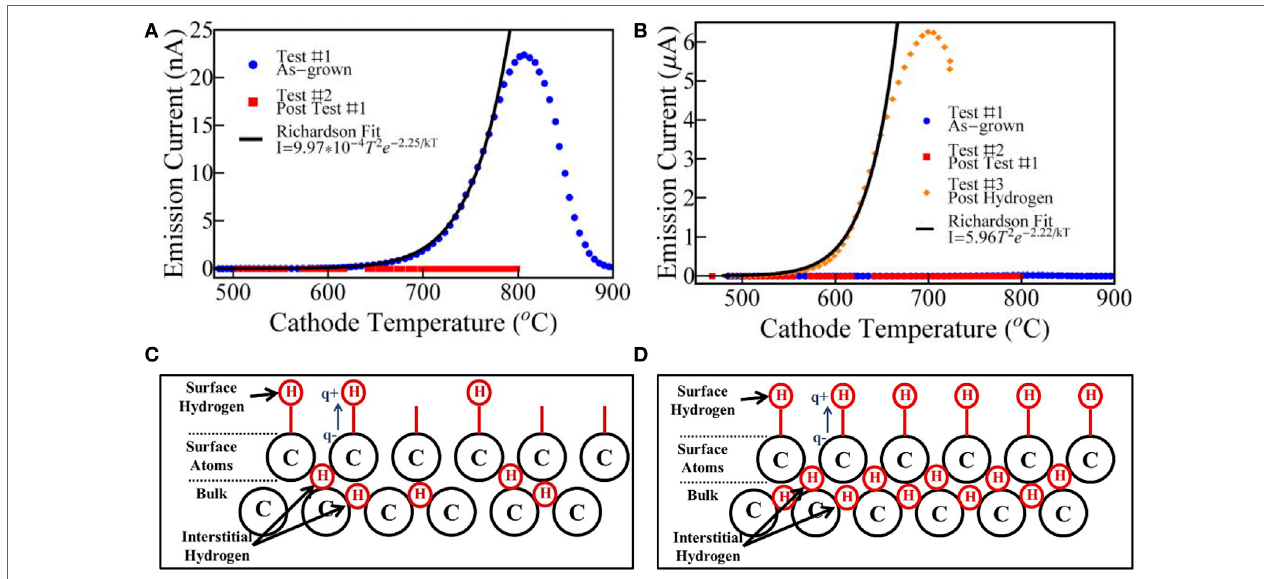
FigURe 2 | The thermionic emission performance between an (A) as-grown nitrogen-incorporated diamond sample and (B) the same sample following exposure to a low energy hydrogen plasma. It was found that this hydrogenation treatment significantly increased the thermionic emission current, primarily through improvement in the emitter’s Richardson constant. It is hypothesized that these results are due to an increased surface and bulk hydrogen concentration upon hydrogenation. Because such samples are grown in a hydrogen-rich environment, there is likely a small amount of hydrogen present in the bulk and on the diamond surface (C) . As hydrogen lowers the electron affinity (and thereby the work function) of diamond, the majority of emission will arise from these surface sites. Upon hydrogenation, surface hydrogen concentration increases leading to more sites for emission (D) . In addition, the increased bulk hydrogen concentration decreases the sample’s resistivity, allowing for a larger flux of electrons traveling normal to the surface. This explanation appears to account for the large observed increase in Richardson constant with little change in work function following hydrogenation. (A,B) Reprinted with permission from Paxton et al. (2012). Copyright 2012, American Vacuum Society. (C,D) Images provided courtesy of W. F.